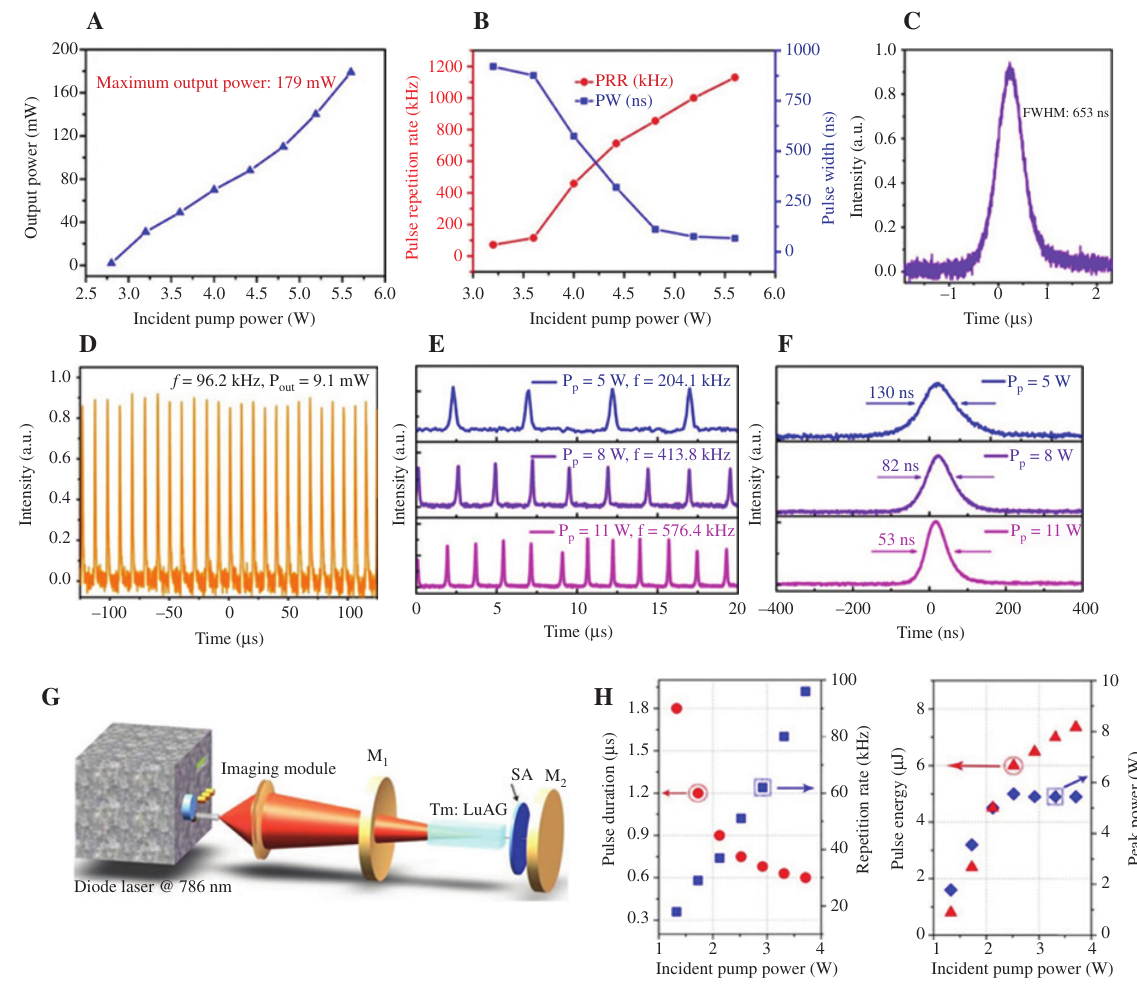
Figure 5: C-QD, C-QD, and FONPs Q-switched lasers. (A) Output power vs. incident pump power, (B) dependence of the pulse repetition rate and pulse duration on the incident pump power of the C-QD Q-switched laser. Reproduced with permission [74]. Copyright 2017, Optical Society of America. (C) Pulse trains and (D) single pulse waveform of CsPbBr perovskite QDs Q-switched laser. Reproduced with permission [73]. Copyright 2017, Optical Society of America. 3 (E) The pulse trains and (F) single pulse profiles of the FONPs Q-switched Nd:YVO laser. (G) Experimental setup of FONPs-SA Q-switched 4 Tm:LuAG laser, and (H) pulse duration, repetition rate, pulse energy, and peak power vs. incident pump power. Reproduced with permission [76]. Copyright 2018, IEEE Photonics